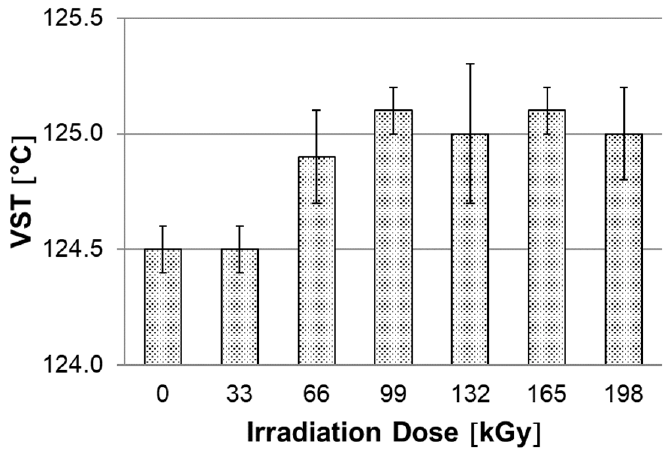
Figure 8. Dependence of Vicat softening temperature (VST) on irradiation dose.